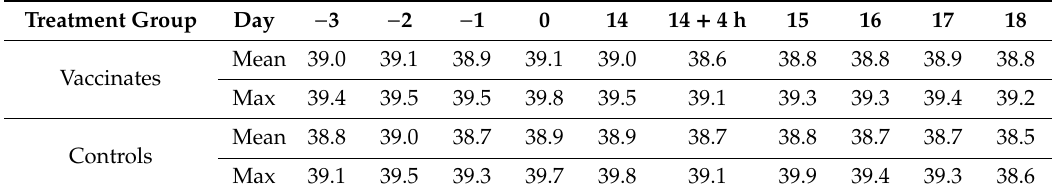
Table 5. Summary of gestation monitoring and o ff